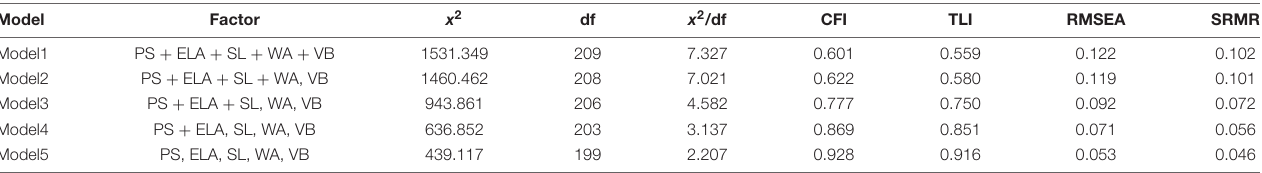
TABLE 1 | Results of confirmatory factor analysis.